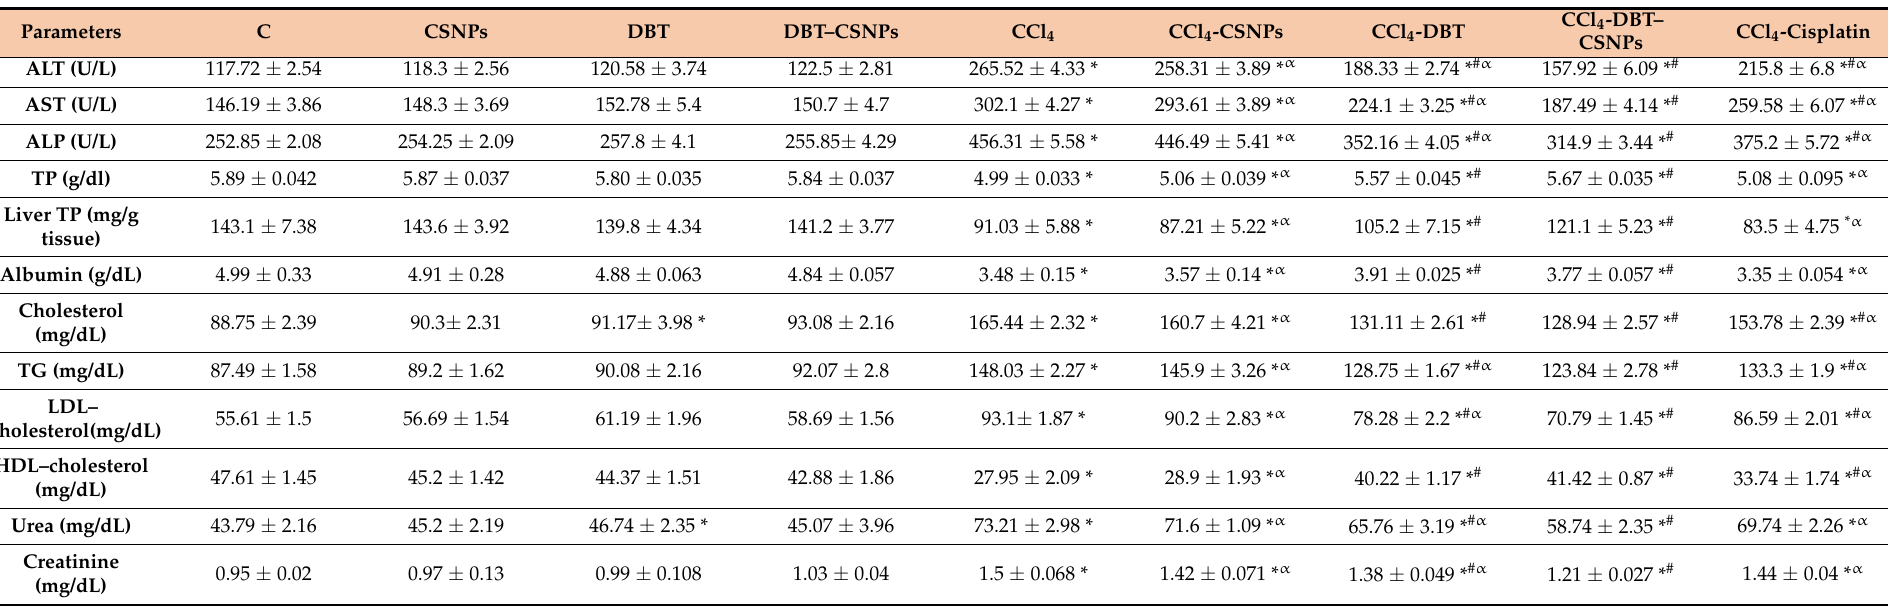
Table 2. Effect of different compounds on the liver, kidney functions, and lipid